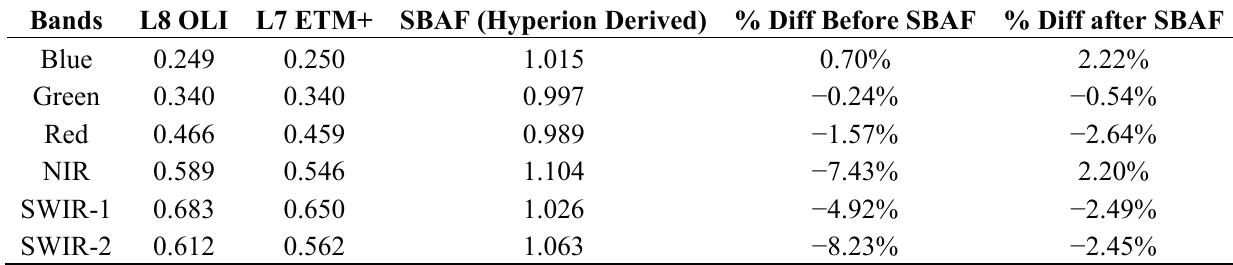
Table 2. Comparison between L7 ETM+ and L8 OLI TOA